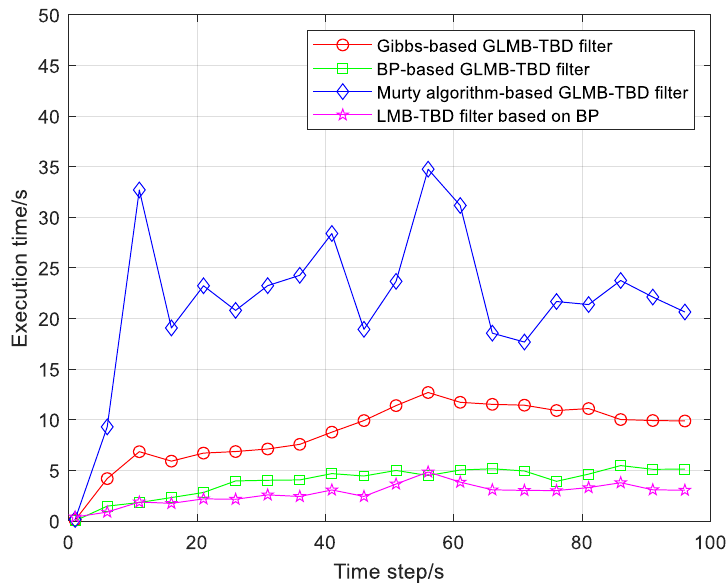
Figure 8. The execution-time curves versus time for different tracking methods.